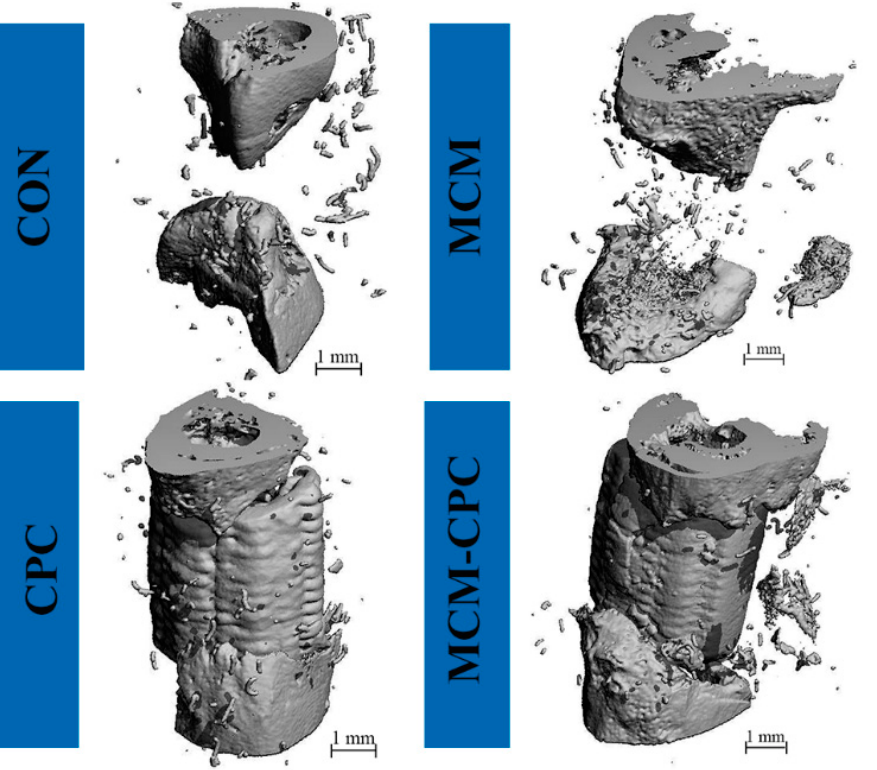
Figure 4. Representative examples of 3D reconstructions of the defect area (ROI) 8 weeks post-surgery as determined by µCT.